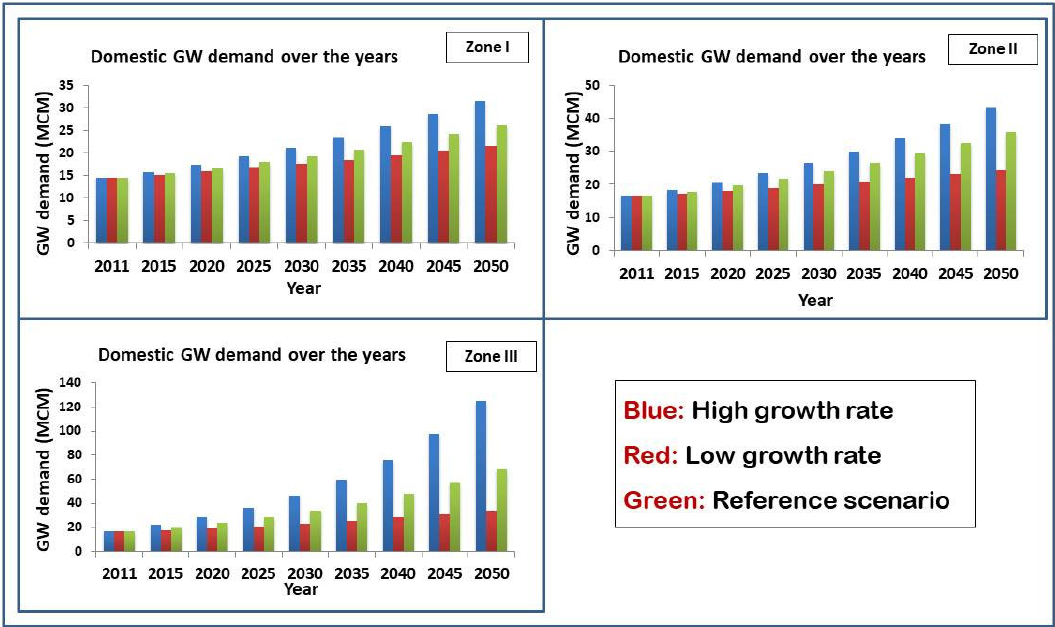
Figure 7. Domestic groundwater demand under different scenarios.